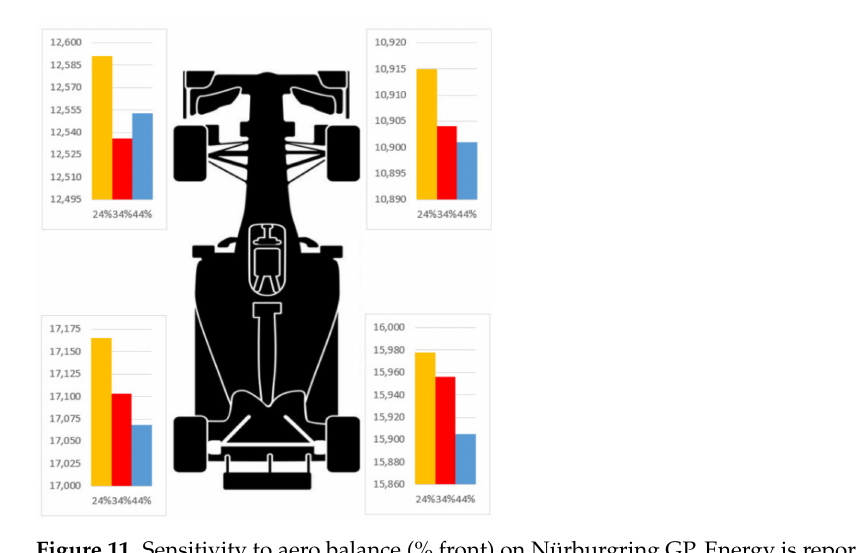
Figure 11. Sensitivity to aero balance (% front) on Nürburgring GP. Energy is reported in kJ.